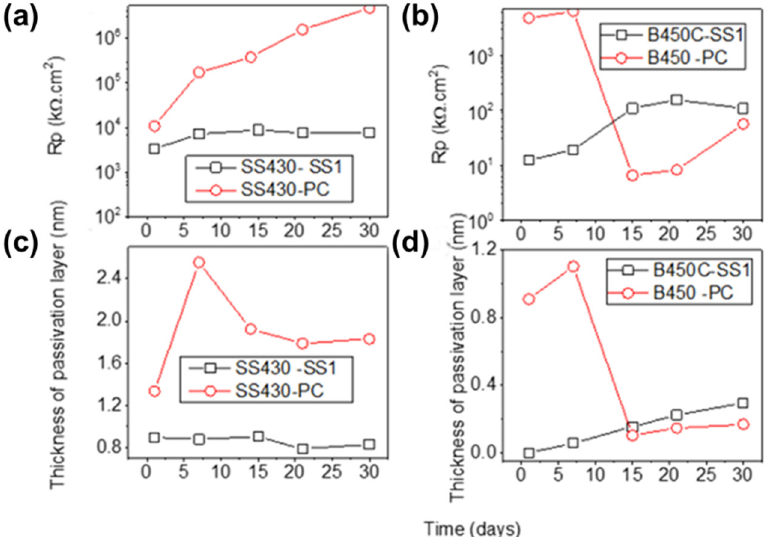
Figure 10. ( a , b ) Evolution of Rp values and ( c , d ) passive-layer thickness during the immersion of SS430 and carbon steel B450C to cement extract solutions of SS1 supersulfated cement (this study) and PC (Portland cement in the absence of chlorides) [41].